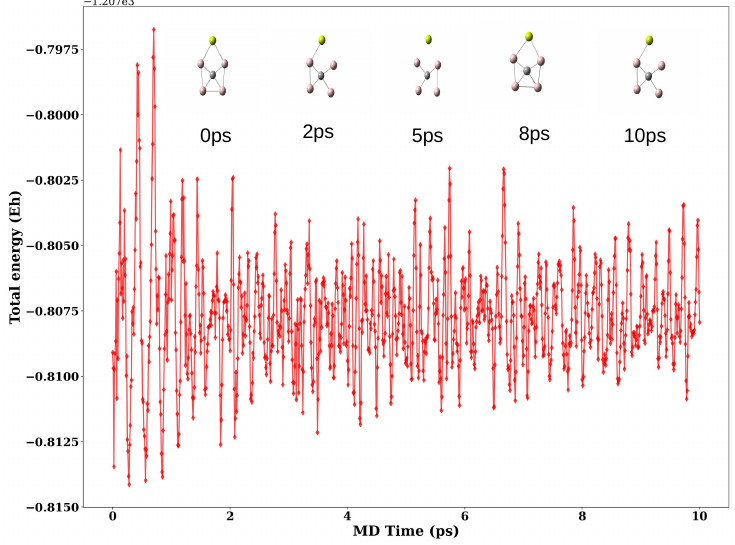
Figure 10. Energy evolution of CAl the ω B97XD/6-311++G(2d,2p)